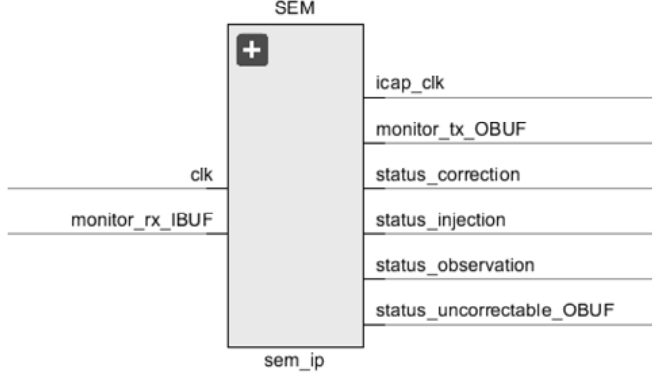
Figure 6. SEM IP entity.